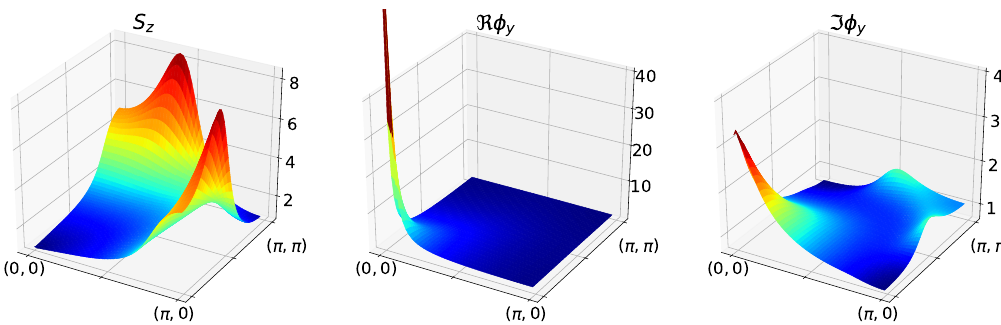
Figure 9: Selected components of the static susceptibility χ ( q ) throughout the Bril- louin zone, for the two-band Hubbard model described in the text, for β =